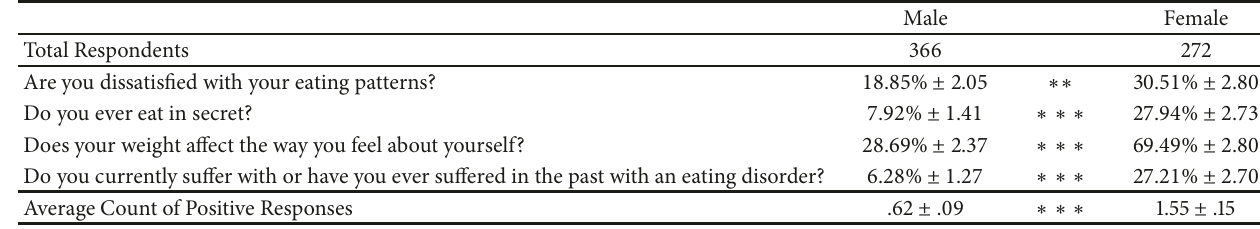
Table 1: Positive response rates to individual questions in the Eating Disorder Screen for Primary Care (ESP) by male and female cross country and track student athletes.